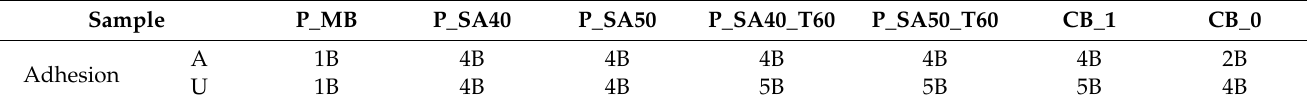
Table 4. Adhesion test results of the formulated paints on steel. According to the ASTM D3359 [43] the adhesion performance is defined in a scale from 1B (the lowest) to 5B (the